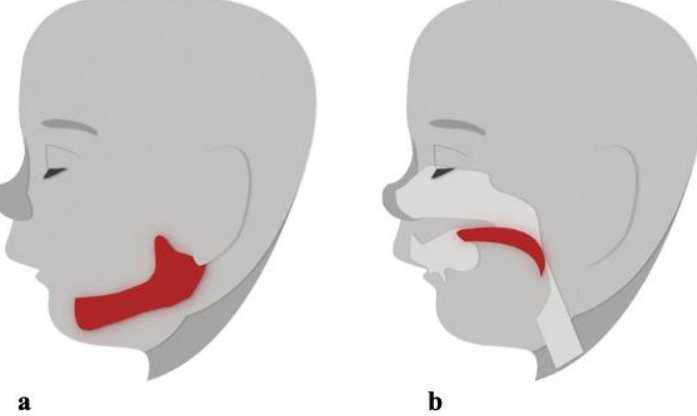
Figure 4. Changes in maxillary-mandibular growth contributes to formation of the ( a ) retrognathic mandible, which may result in decreased space between the cervical column and mandible, leading to the ( b ) posteriorly postured tongue and soft palate, resulting in airway obstruction [41].